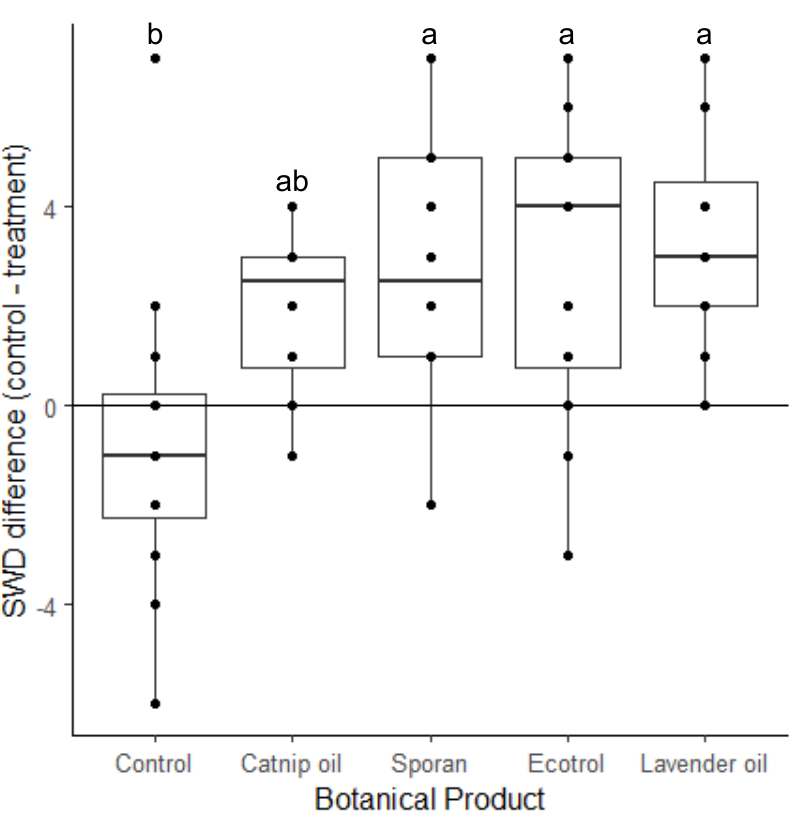
Figure 2. The difference in the number of D. suzukii (spotted-wing drosophila, SWD) between the untreated vials minus the number of SWD in the treated vials. The control treatment is the difference between two untreated vials. Data points above 0.00 indicate a greater number of flies in the untreated vials than the treated vials. Letters denote significant differences at the α = 0.05 level (F = 11.49, df = 5, 55, p < 0.001).